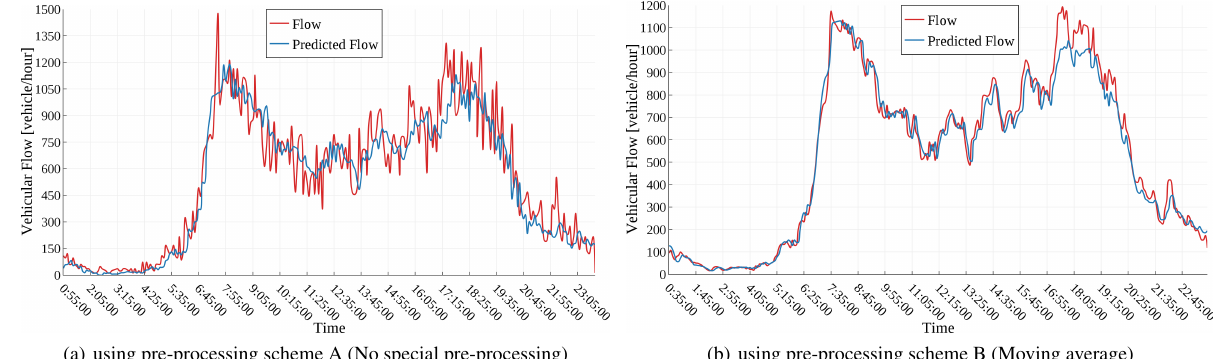
Figure 7. Predicted traffic flow vs actual traffic flow for CGA intersection VF northbound dataset consisting of a weekday